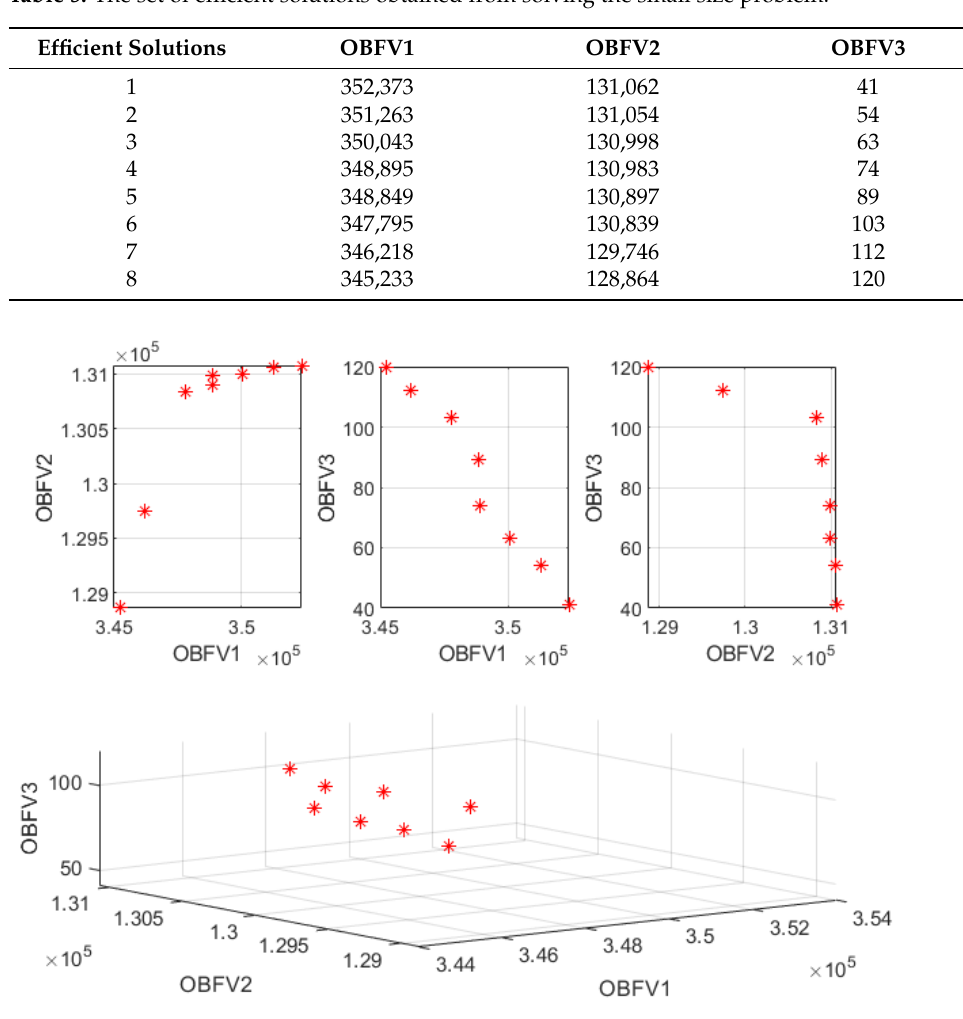
Table 5. The set of efficient solutions obtained from solving the small size problem.